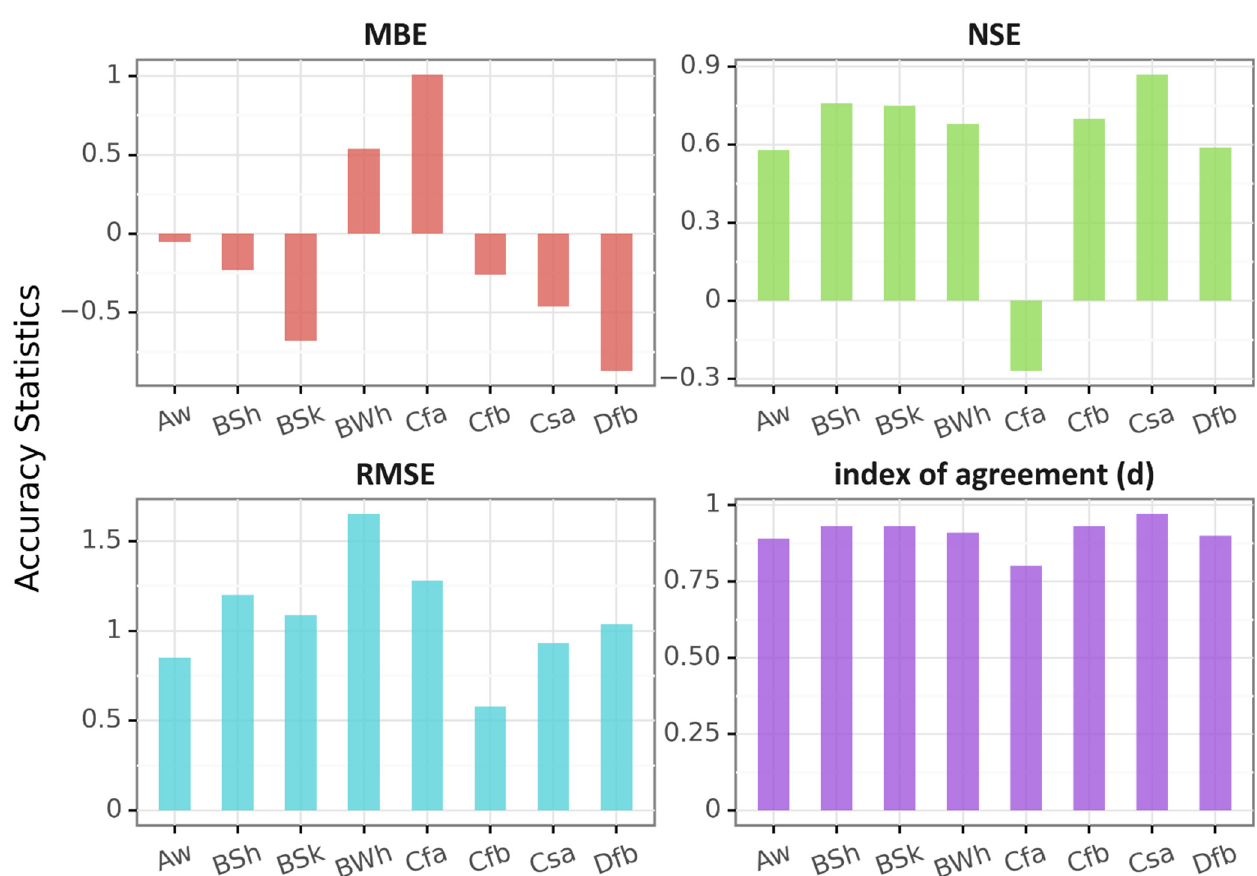
Figure A1. Daily AgSAT and station ETref scatterplots comparisons for the 18 studied locations grouped by the climatic region, the grey line represents the 1:1 line. AE*: Aguas Emendadas.